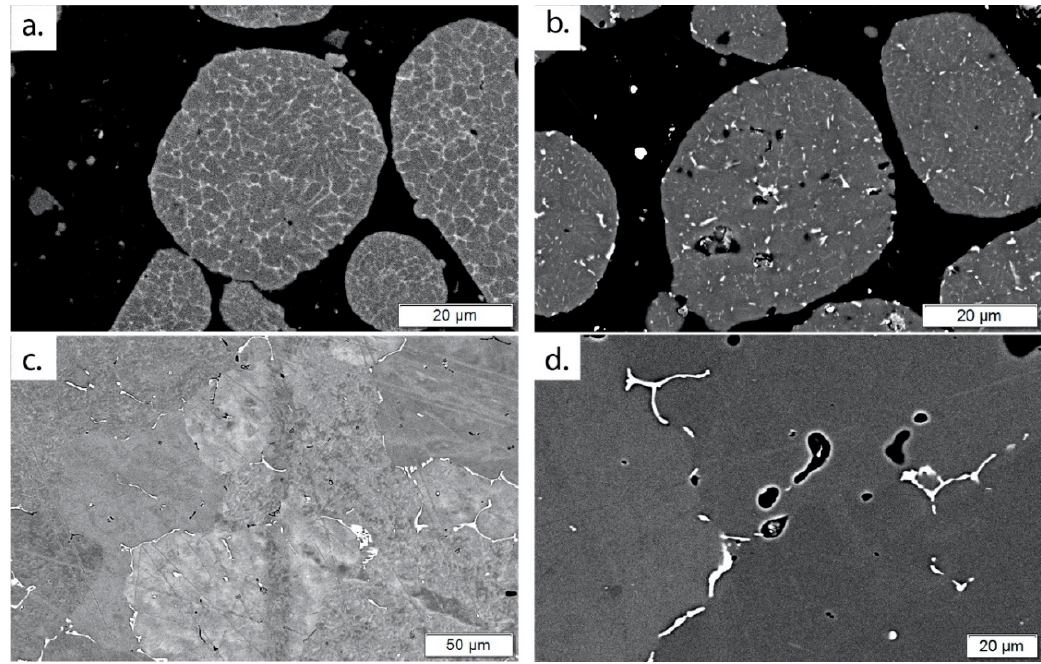
Figure 9. Electron micrographs comparing the microstructures of the as-cast ( c ), as-atomized ( a ), thermally treated cast ( d ), and thermally treated gas-atomized powder ( b ) via SEM for Al 7075.